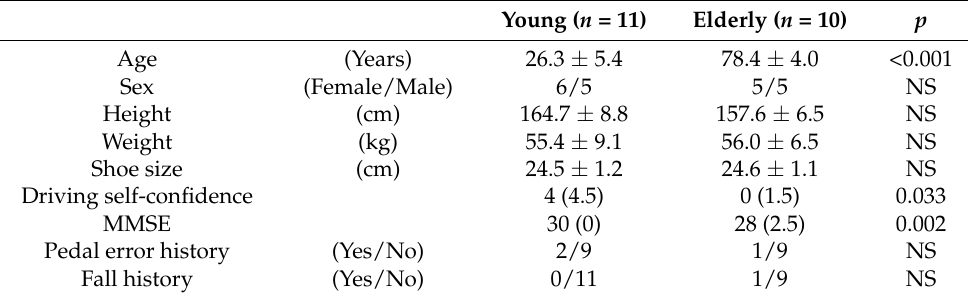
Table 1. Characteristics of the